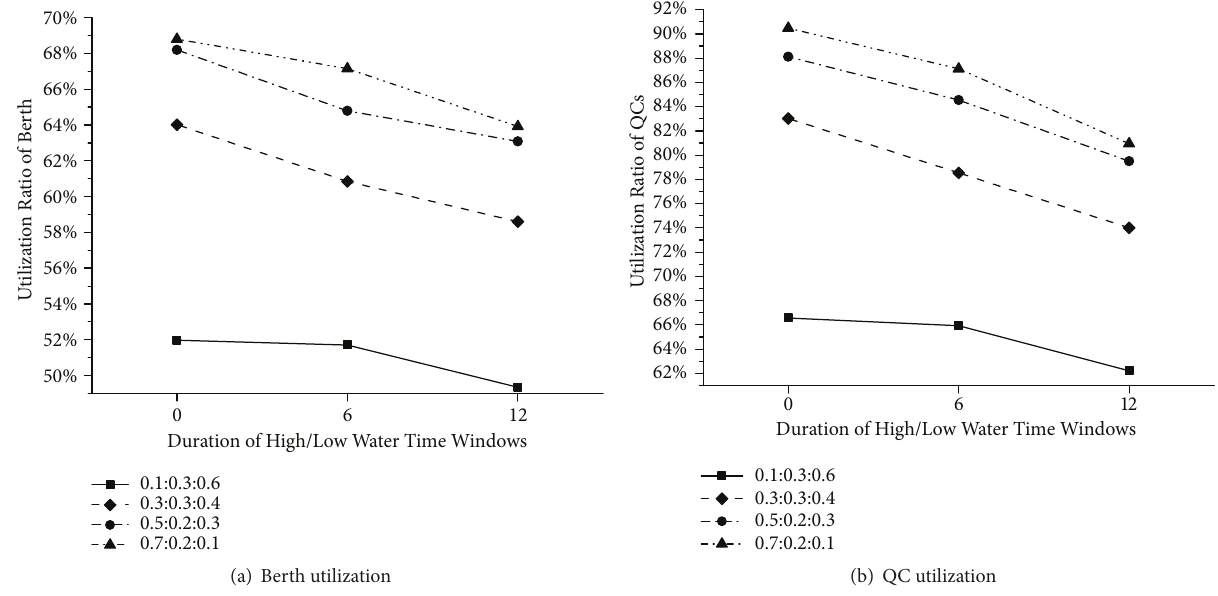
Figure 9: Tidal impact on berth and QC